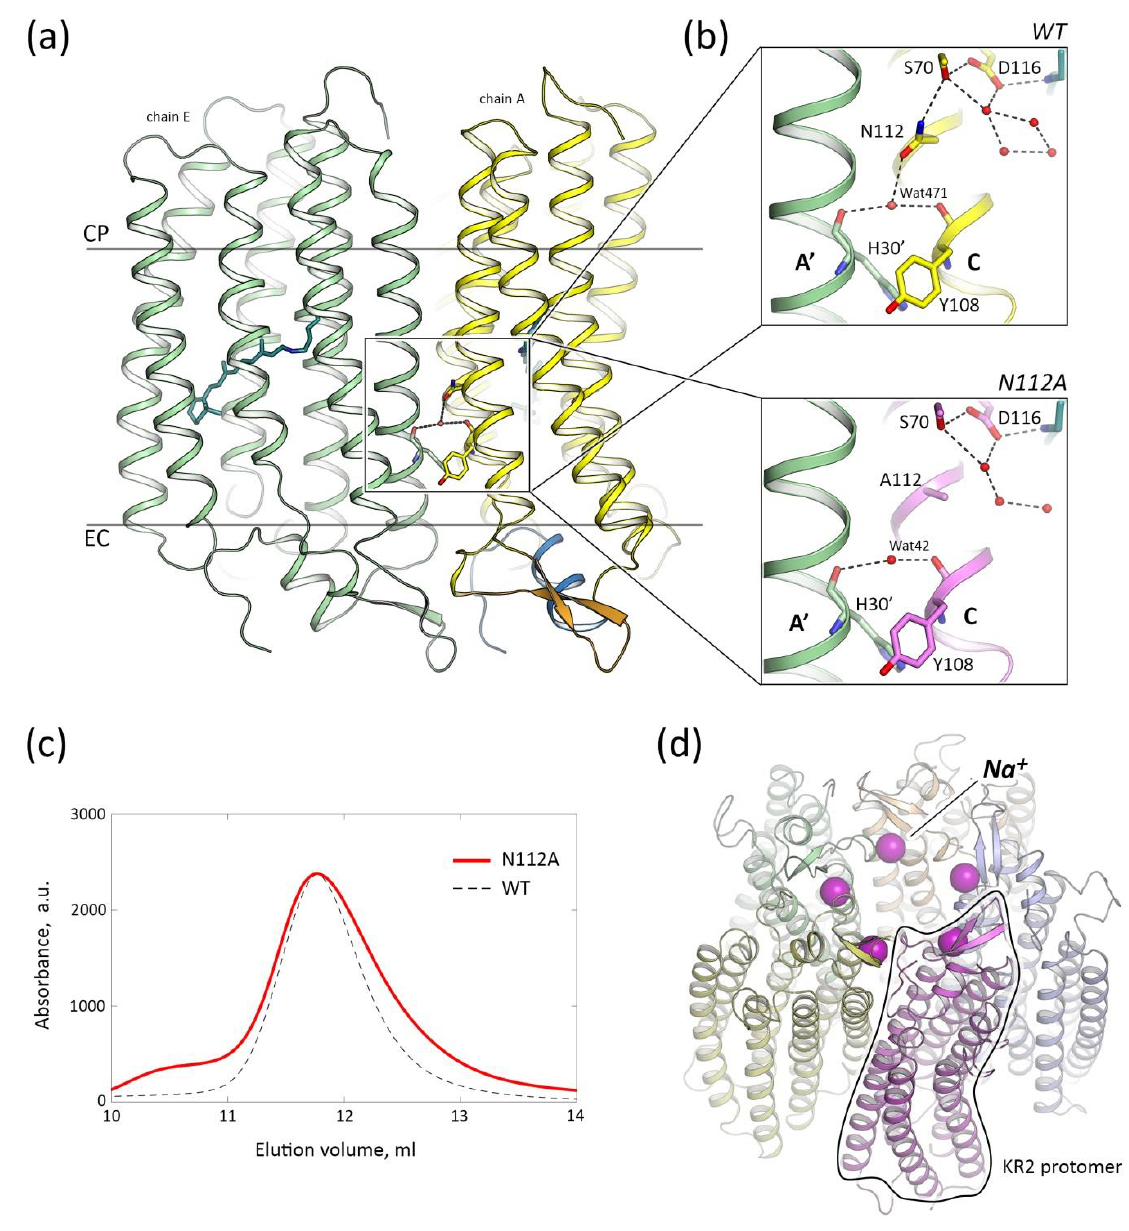
Figure 1. Pentameric organization of KR2-N112A. ( a ) Side view of two neighboring protomers (chain A, yellow and chain E, green of the 6YC3 model) of KR2 pentamer in the membrane. N-terminal α -helix of chain A is colored blue. BC loop of the chain A is colored orange. Cytoplasmic (CP) and extracellular (EC) sides of the membrane are marked. ( b ) Detailed view of the inter-protomers contacts in the region of the N112 of the WT (top part) and A112 of the N112A mutant (bottom part). Neighboring protomer is colored green. The retinal cofactor is colored teal. Helices are marked with bold capital letters. ( c ) Size-exclusion chromatography (SEC) profiles of the N112A mutant (red line) and WT KR2 (black dashed line). The position of the absorption peak is the same for the WT KR2 and N112A variant (~11.8 mL when using 24 mL Superdex 200i column). The absorption was measured at 525 and 522 nm for the WT [21] and N112A [42] KR2, respectively. The small left peak of the KR2-N112A profile likely corresponds to the fraction of the aggregates. ( d ) KR2-N112A pentamer, view from the cytoplasmic side. Sodium ions, located at the oligomerization interface, are shown with purple spheres. One of five KR2 protomers is contoured for clarity.